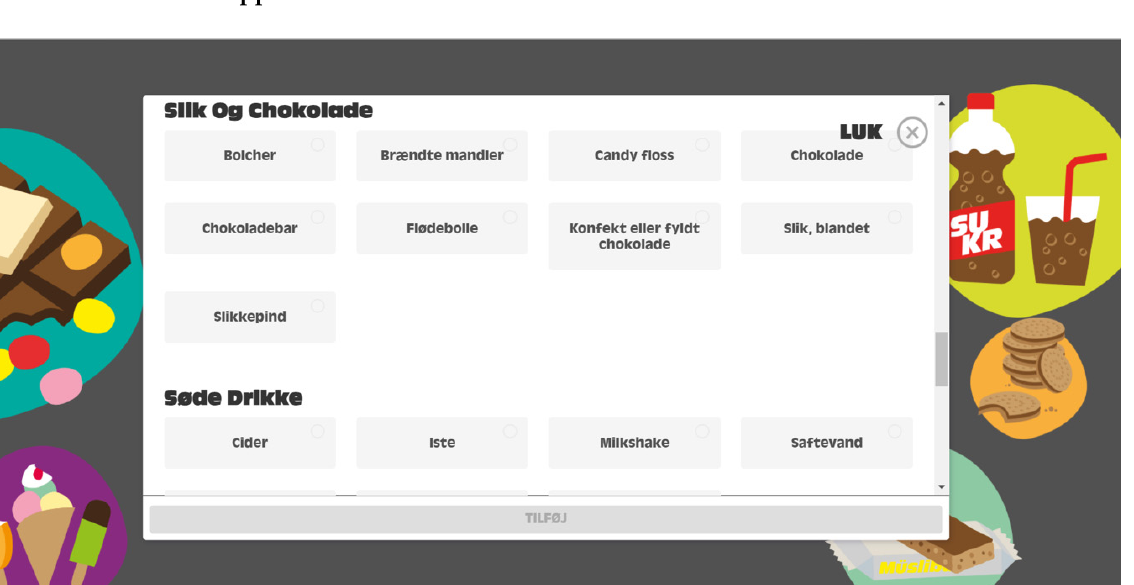
Figure A2. Screen shot from the SRFS. Website where parents chose the portion size of each discretionary food or drink their child had consumed and at which days this specific food was consumed. The pictures to the left and right are referring to portions of the same size. References 1. Vos, M.B.; Kaar, J.L.; Welsh, J.A.; Van Horn, L.V.; Feig, D.I.; Anderson, C.A.M.; Patel, M.J.; Cruz Munos, J.; Krebs, N.F.; Xanthakos, S.A.; et al. Added sugars and cardiovascular disease risk in children: A scientific statement from the American Heart Association. Circulation 2017 , 135 , e1017–e1034. https://doi.org/10.1161/CIR.0000000000000439. 2. World Health Organization. Guideline: Sugars Intake for Adults and Children ; World Health Organization: Geneva, Switzerland, 2018; Volume 57, pp. 1716–1722. 3. Rupérez, A.I.; Mesana, M.I.; Moreno, L.A. Dietary sugars, metabolic effects and child health. Curr. Opin. Clin. Nutr. Metab. Care 2019 , 22 , 206–216. https://doi.org/10.1097/MCO.0000000000000553. 4. Malik, V.S.; Hu, F.B. Sugar-sweetened beverages and cardiometabolic health: An update of the evidence. Nutrients 2019 , 11 , 1840. https://doi.org/10.3390/NU11081840. 5. Bleich, S.N.; Vercammen, K.A. The negative impact of sugar-sweetened beverages on children’s health: An update of the literature. BMC Obes. 2018 , 5 , 6. https://doi.org/10.1186/S40608-017-0178-9. 6. Luger, M.; Lafontan, M.; Bes-Rastrollo, M.; Winzer, E.; Yumuk, V.; Farpour-Lambert, N. Sugar-Sweetened Beverages and Weight Gain in Children and Adults: A Systematic Review from 2013 to 2015 and a Comparison with Previous Studies. Obes. Facts 2018 , 10 , 674–693. https://doi.org/10.1159/000484566. 7. Lyhne, N.; Ovesen, L. Added sugars and nutrient density in the diet of Danish children. Scand. J. Nutr. 1999 , 43 , 4–7.